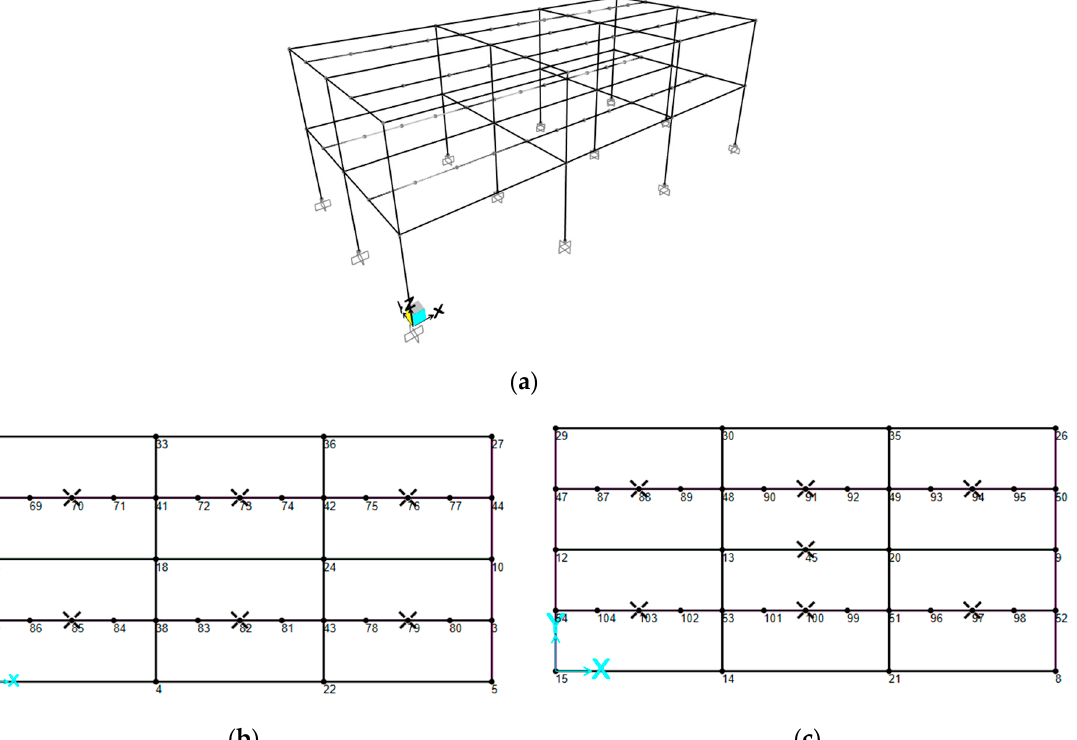
Figure 9. ( a ) Numerical model of the “index” building ( b ) control points on the first storey ( c ) control points on the upper slab.